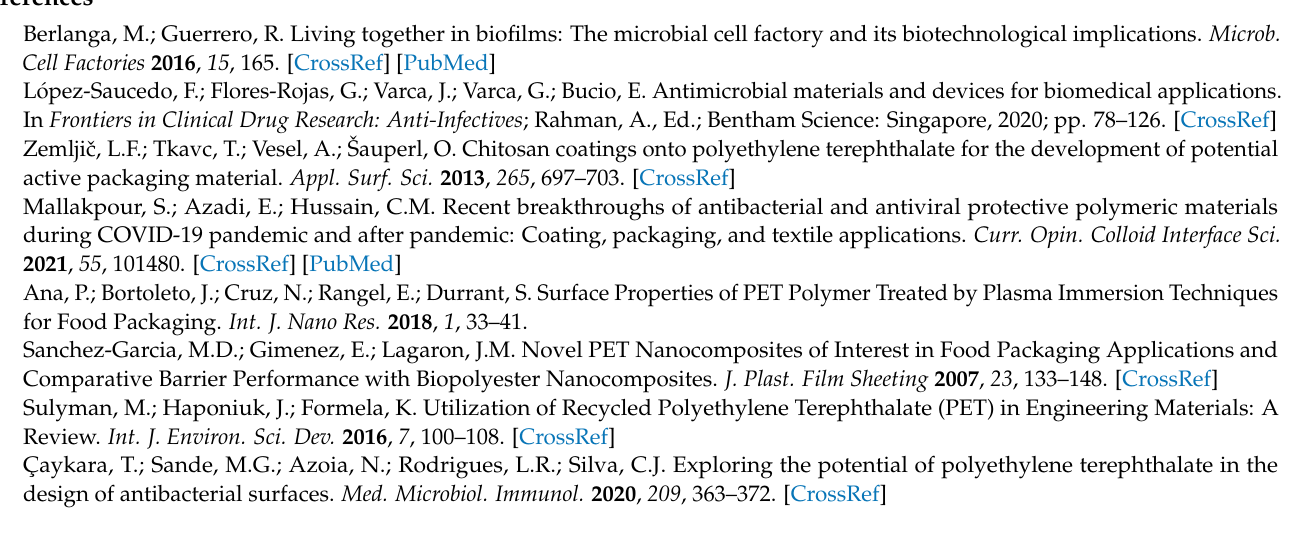
Summary; Table S3: Means; Table S4: Grouping Information Using the Fisher LSD Method and 95% Confidence; Figure S1: Fisher individual 95%; Figure S2: Interval plot of control PET; Figure S3: Individual value plot of control PET; Figure S4: Boxplot of control PET; Figure S5: Normal Probability Plot; Figure S6: Versus fits; Figure S7: Histogram of residual